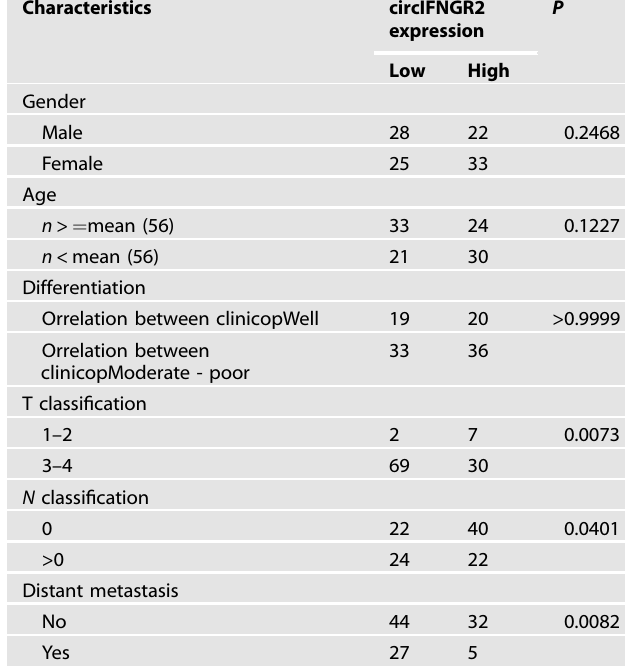
Table 1. Correlation between clinicopathological features and circIFNGR2 expression in 108 CRC